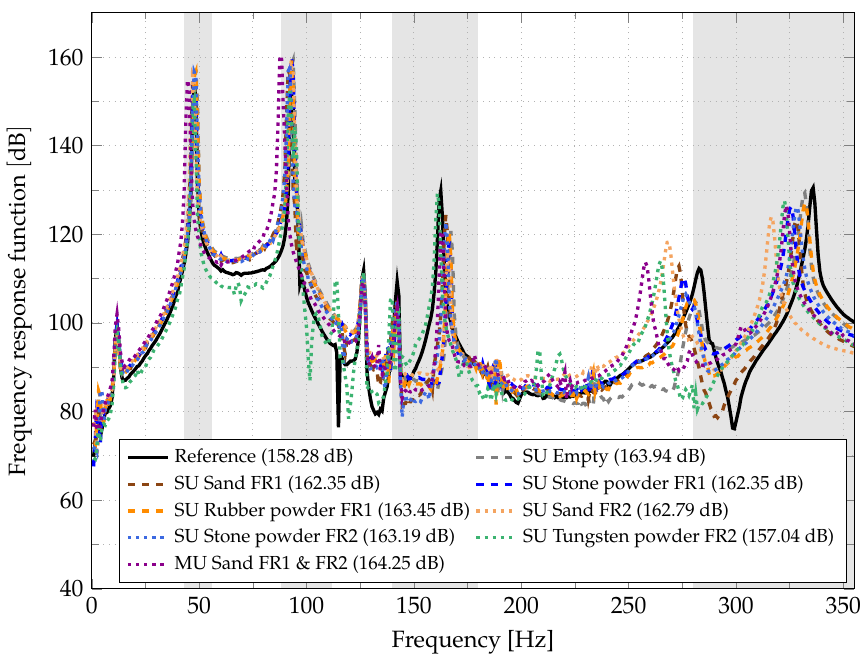
Figure A6. Narrow band plot: FRF of SU and MU HCDP mounted between stator arm and stator ring with SL of surface velocity in dB.